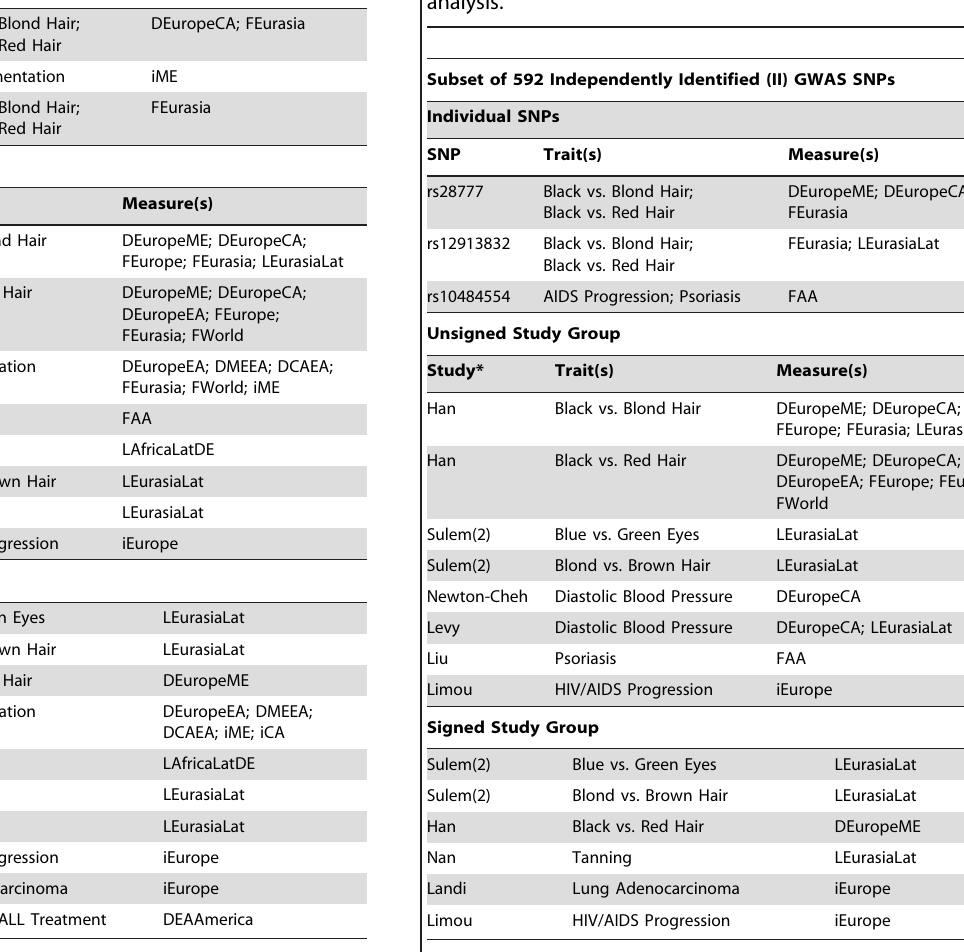
Full Set of 1,336 CEPH-HGDP GWAS SNPs Subset of 592 Independently Identified (II) GWAS SNPs P-Value Cutoff for Signifi- cance at 0.05 Level*